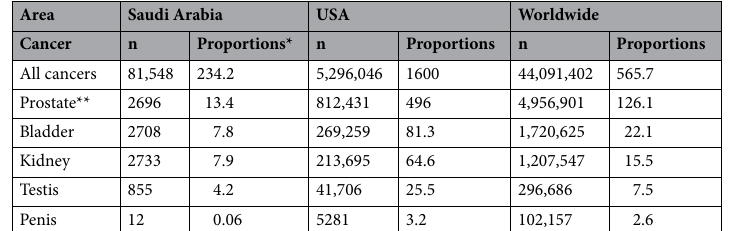
Table 6. Estimated number of 5-year prevalent cases in 2020 of genitourinary tumors according to the geographical region, both sexes, all ages 74 . *Prevalence per 100,000 population. **Prevalence in males only.